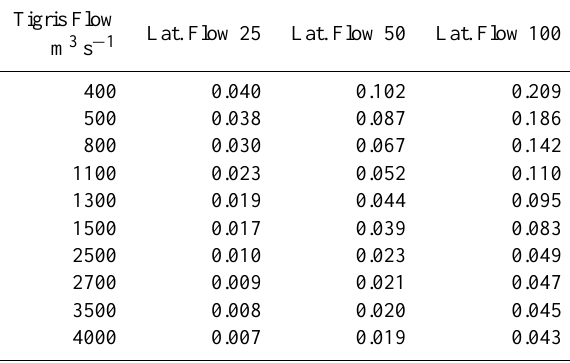
Table 3. Average differences in water elevation (m) for each sce- nario with respect to base